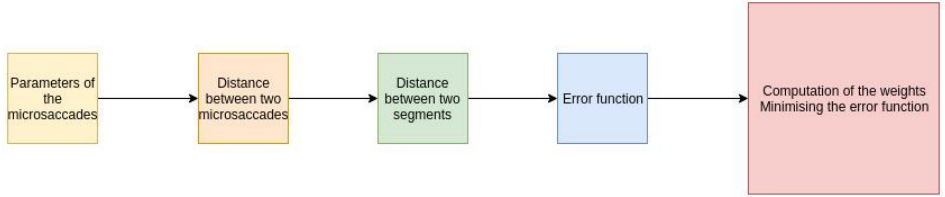
Figure 4. A set of definitions needed to implement the algorithm.